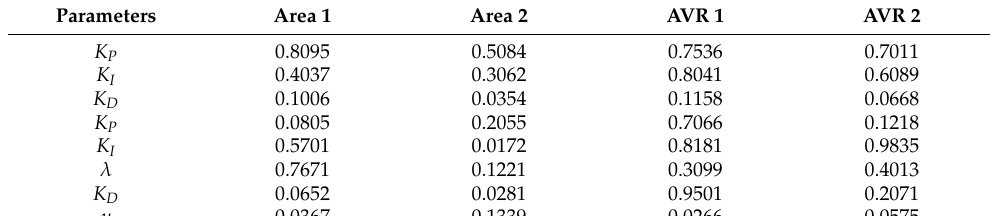
Table 17. Cascaded PID-FOPID controllers’ gain for delay at T d = 1.85 s.